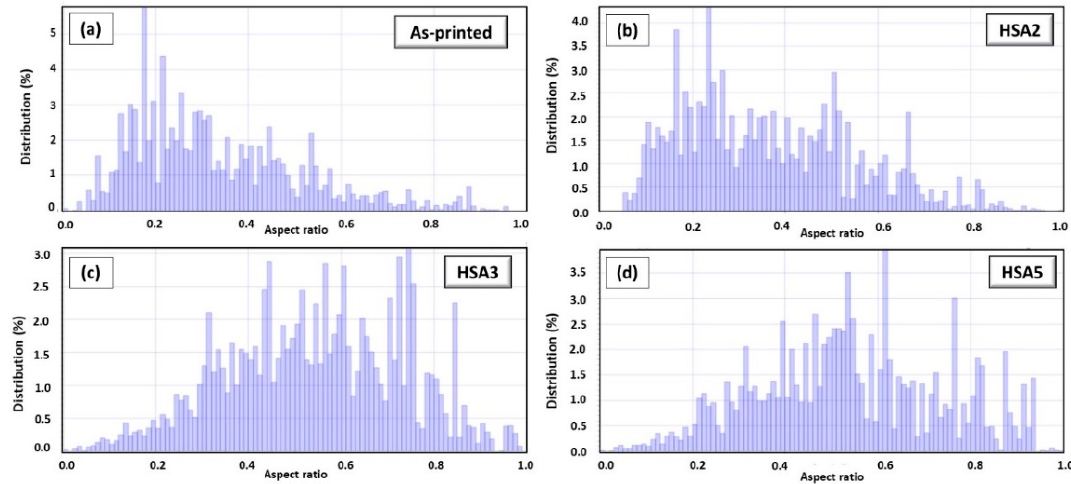
Figure 10. Grain morphology distribution displaying the change in grains aspect ratio as a function of heat-treatment conditions: ( a ) as-printed; ( b ) HSA2; ( c ) HSA3; ( d ) HSA5.